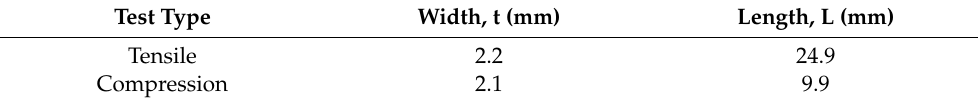
Table 3. Specimen dimensions.